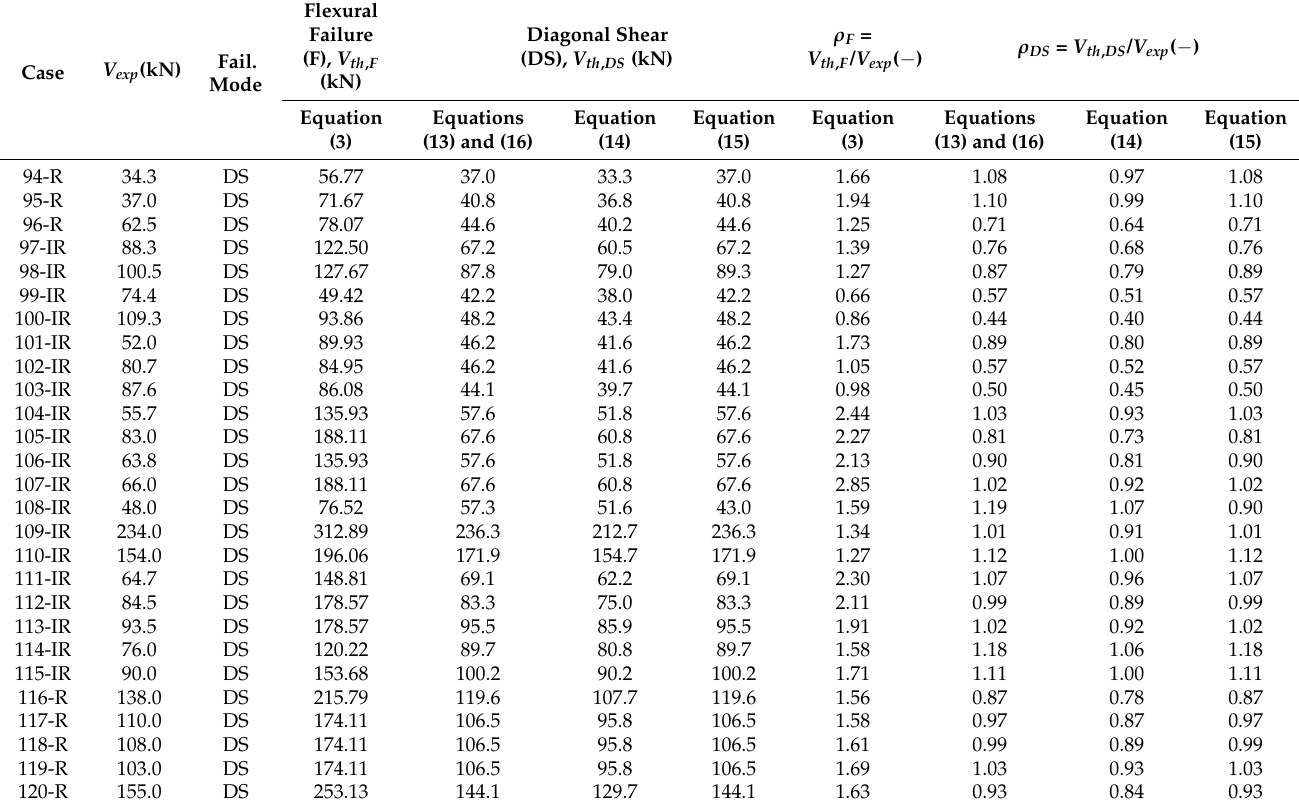
Table 9. Theoretical results and comparison with the experimental results for irregular/rubble